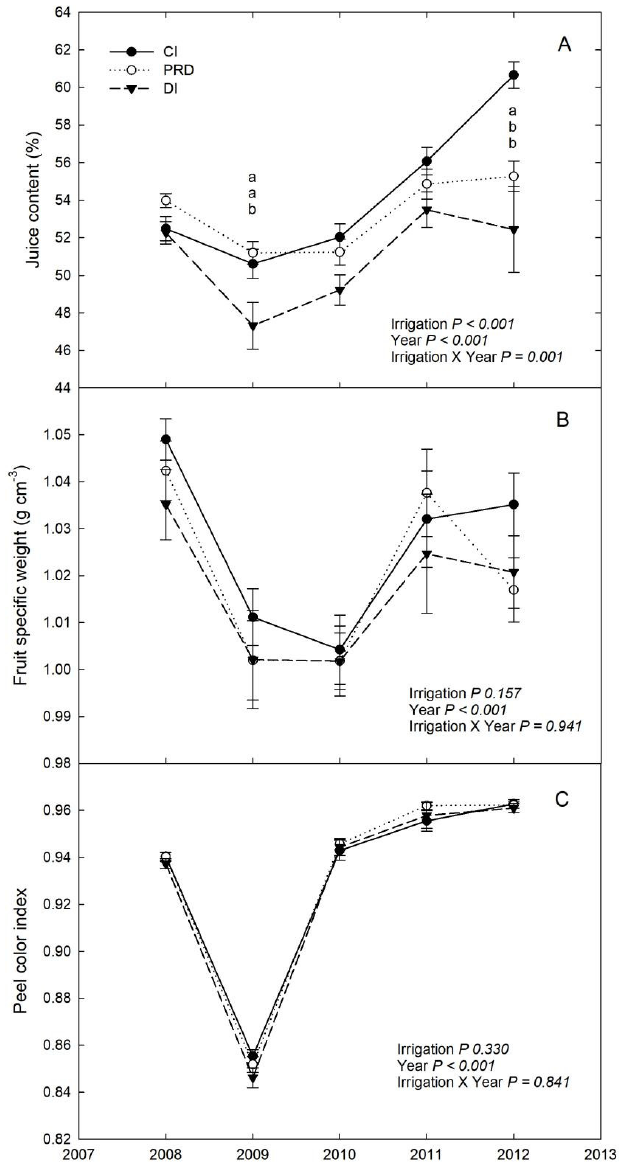
Figure 4. Juice content ( A ), fruit specific weight ( B ), and peel color index ( C ) in adult ‘Valencia’ orange trees under conventional irrigation (CI), partial rootzone drying (PRD), and continuous deficit irrigation (DI). Error bars are standard errors of the means. P-values in each panel are for main factors and interactions from the ANOVA models. When present, lower-case letters indicate significant differences among irrigation levels in a specific year (Tukey’s multiple range test, p < 0.05). In 2010, the juice concentration of total carotenoids and vitamin C was higher in DI fruits than in CI fruits, and intermediate in PRD fruits (Table 1). This was not due to fruit dehydration as using